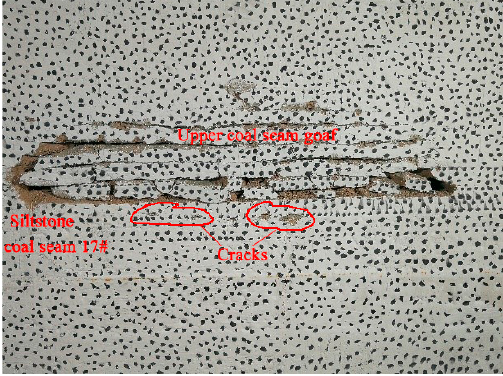
Figure 9. State of completion of upper coal seams mining.